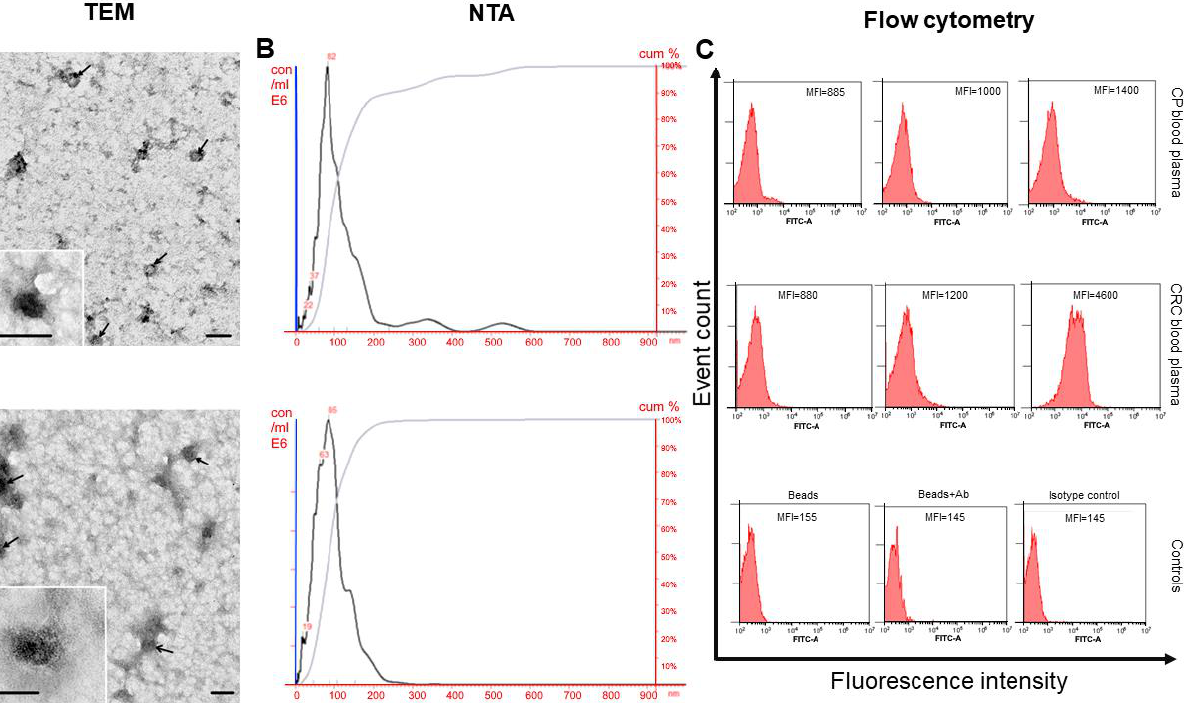
Figure 1. Identification of isolated sEVs. ( A ) TEM showed the presence of vesicles with typical morphology and no vesicles larger than 100 nm. The inserts show sEVs. Scale bars correspond to 100 nm. Electron microscopy, negative staining with uranyl acetate; ( B ) size distribution of plasma sEVs isolated from the blood of CPPs and CRCPs. Data of NTA analysis; ( C ) expression of CD63, CD81, and CD24 on CD9 - positive sEVs of blood plasma CPPs and CRCPs. Representative median fluorescence intensity (MFI) values are shown for flow cytometry. Each study was performed in triplicate. For isotype controls (histogram at right), labeled CD9 bead–sEV complexes were incubated with mouse FITC IgG1, k Isotype control or mouse FITC IgG2a, k Isotype control. One of the representative isotypic controls is shown. For the negative control, nothing was added to the CD9 antibody - labeled latex particles (histogram at left) or incubated with FITC - labeled antibodies (anti - CD63, anti - CD81, or anti - CD24). One of the representative negative controls is shown (histogram in the center). Particles called “non - vesicles” (low - or very - low - density lipoproteins) were also present in the samples. The lipoproteins could not be separated from the sEV preparations by any of the methods used to isolate sEVs from body fluids. NTA showed that the sEVs of blood plasma CPPs and CRCPs had similar sizes: the sEVs of plasma CPPs had a mean size of 108 nm with a mode of 71 nm and an SD of 50 nm; the sEVs of plasma CRCPs had a mean size of 94 nm with a mode of 70 nm and an SD of 56 nm (Figure 1B). The mean concentration of EVs isolated from plasma CPPs and CRCPs was not significantly different (39.7 ± 7.0 × 10 9 particles/mL blood and 30.8 ± 3.9 × 10 9 particles/mL blood, respectively). The sEVs absorbed on aldehyde sulfate latex beads using anti - CD9 antibodies were stained with FITC - labeled antibodies to the CD63 and CD81 tetraspanin family receptors, as well as antibodies to the CD24 receptor. Similar plasma sEV subpopulation compositions were found in CPPs and CRCPs, and a statistically significant difference between polyp and cancer patients was found in the MFI of the CD9/CD24 sEV subpopulation (Figure 1C).